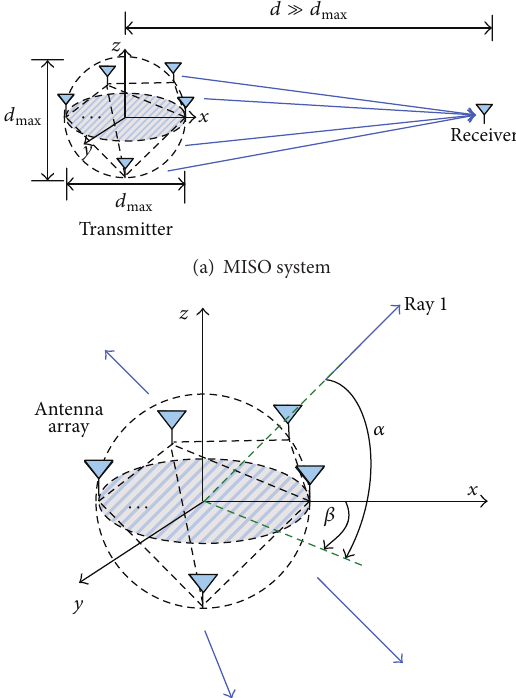
Figure 1: System